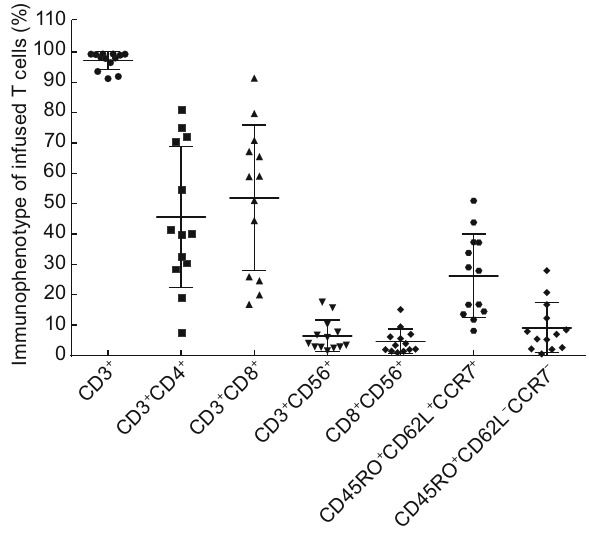
Figure 1. Phenotype of the cultured CART-HER2